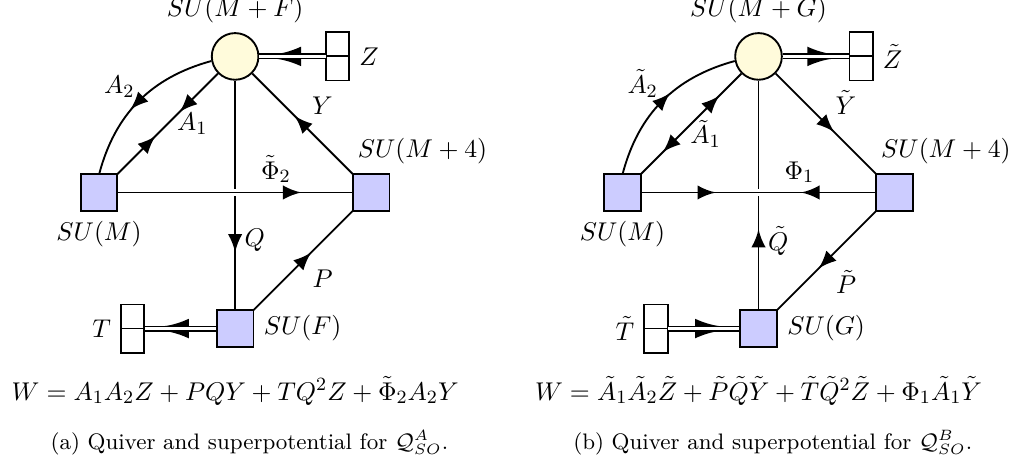
Figure 12. The two deconfined quivers for q The q SO